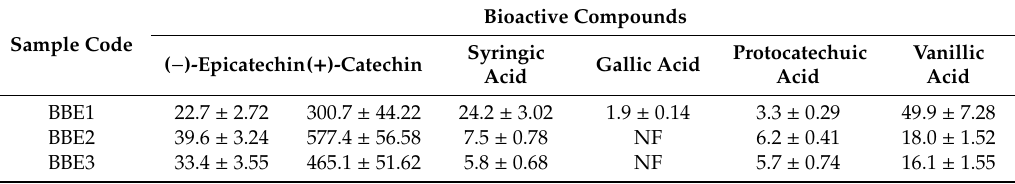
Table 4. Quantitative ( µ g / g dry plant material) evaluation of the recovery of main bioactive compounds in samples of BBE.